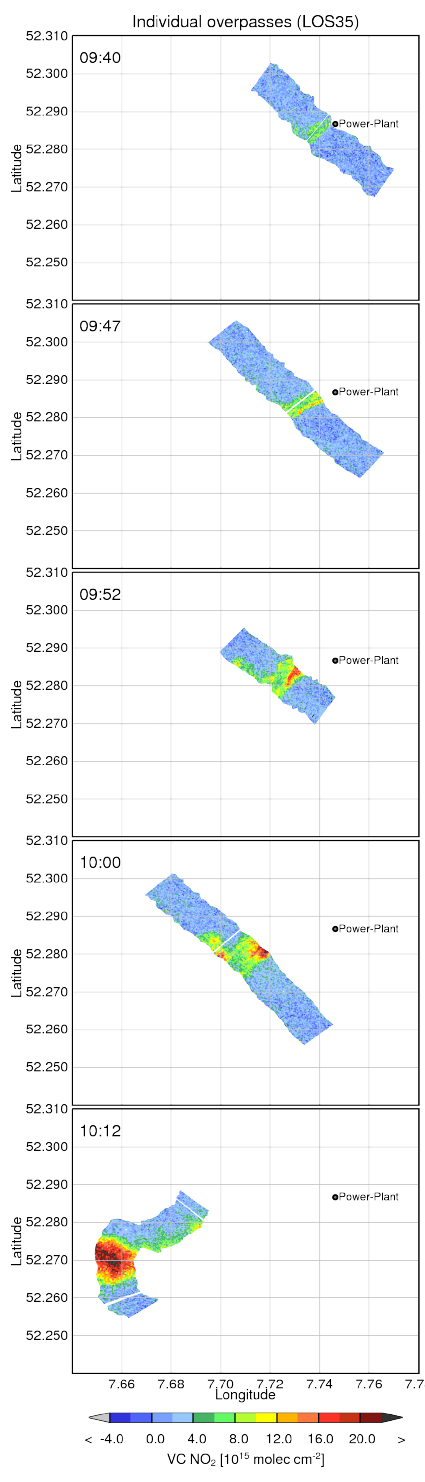
Figure 13. Overpasses at five different times between 09:40 and 10:12 UTC over the NO 2 plume. Data from the LOS35 analysis are shown. The latest overpass at 10:12 UTC has a distance of around 6km from the power plant and is used for the emission flux calcu-